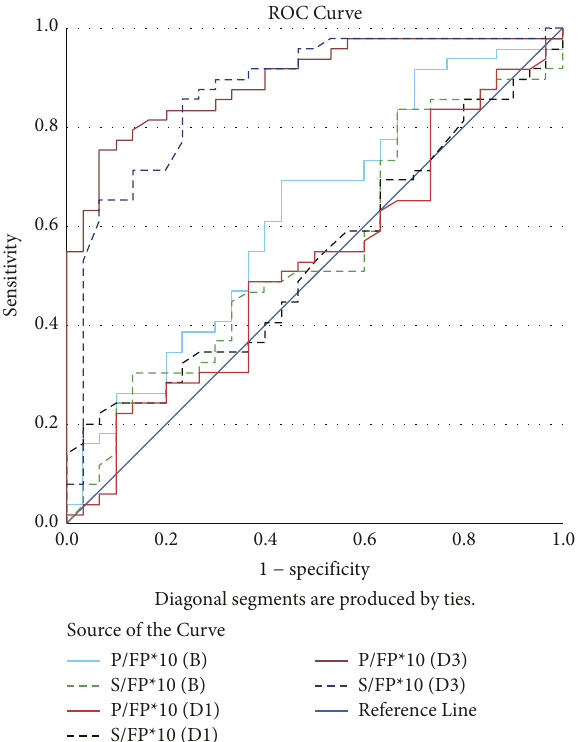
Figure 4: The ROC of the change in the P/FP ∗ 10 and S/FP ∗ 10 ratios from baseline and day one to day three to predict survival. The AUC of the P/FP (D3-B) is the highest (AUC: 0.902, cut-off ≥ 34.25), followed by the AUC of S/FP (D3-B) (AUC: 0.877, cut-off ≥